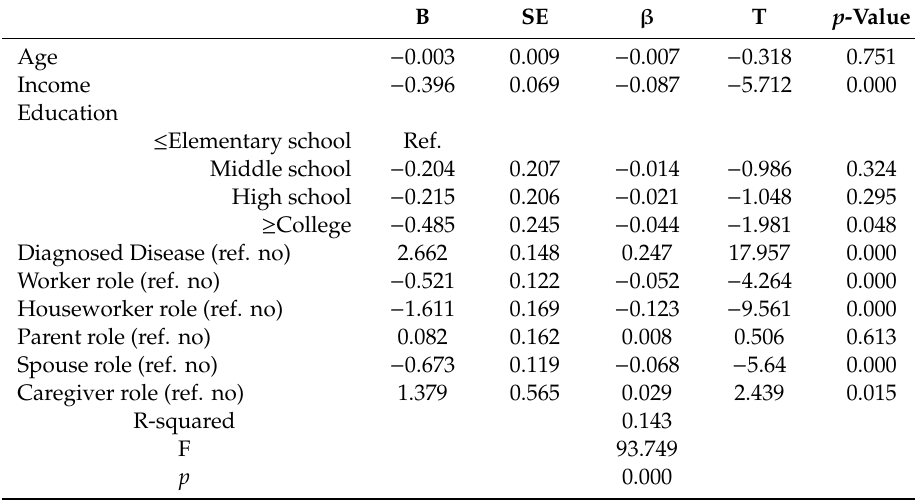
Table 2. E ff ects of role fulfillment on depressive